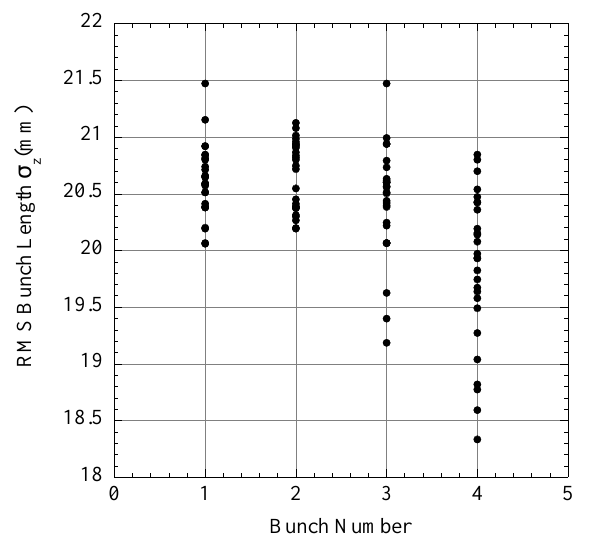
FIG. 10. The bunch length for the four bunches in the train. The mean bunch length for bunches 1 through 4 are 20.6 6 0.3 , 20.7 6 0.3 , 20.4 6 0.5 , and 19.8 6 0.7 mm, respectively.